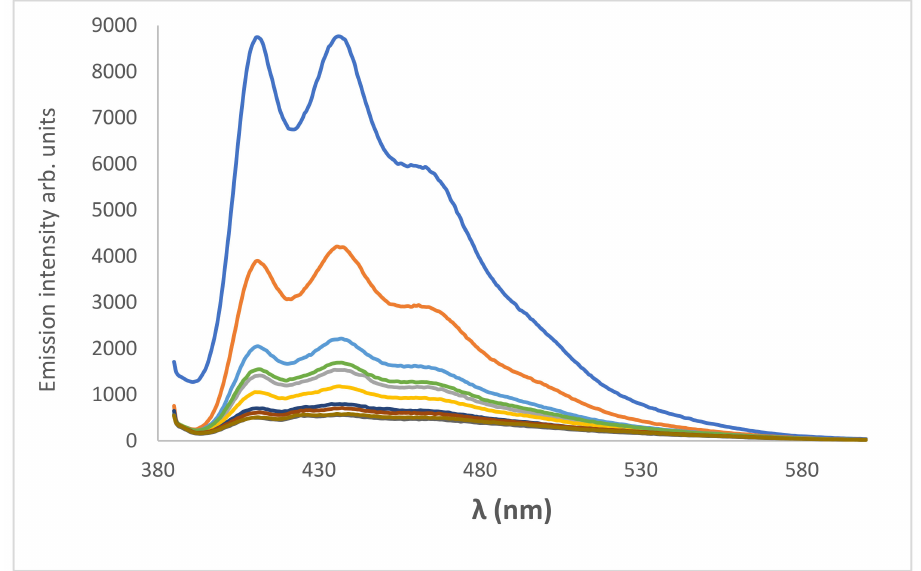
Figure 22. Fluorescence spectra of 7.5 × 10 − 5 M of 2-amino-4-hydroxy-6-(4-hydroxy-2-oxo-2H- chromen-3-yl)nicotinonitrile 4 ; decrease in emission intensity at increasing [Cu 2+ ]: 0, 2, 4, 6, 8, 10, 15, 20, 25 µ M, λ ex = 376